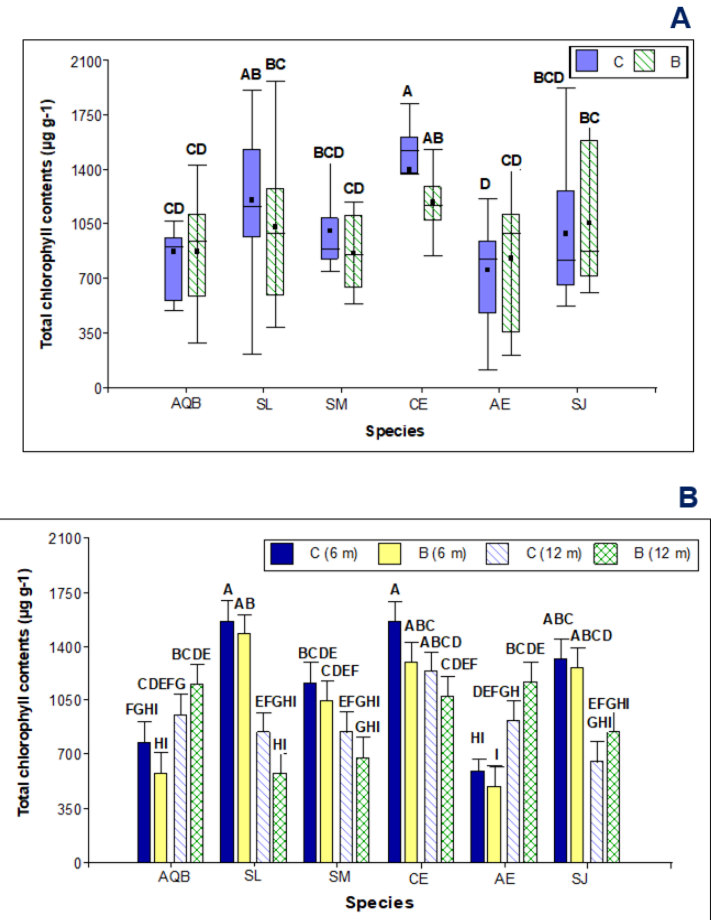
Figure 1. ( A ) Content of total chlorophyll in response to experimental burns (EB) expressed in µ g g − 1 dry weight. A black line within the box marks the median, a black point within the box marks the mean, and the boundary of the box farthest from zero indicates the third quartile (Q3). Whiskers above and below the box indicate the 10th and 90th percentiles. ( B ) Comparison of total chlorophyll contents considering the time elapsed after EB 2016 (6 and 12 months). Different letters indicate significant differences, according to LSD Fisher pairwise comparison procedure with α : 0.05, n = 30 individual plants by treatment each sampling date. In each figure (B) = Burnt plants; (C) = Control plants. References: SM = S. mistol , SJ = S. johnstonii , SL = S. lorentzii , AE = A. emarginata , AQB = A. quebracho-blanco , CE = C. ehrenbergiana